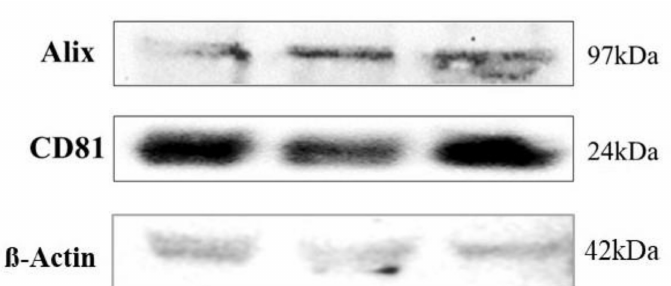
Figure 2. Western Blot results. Characterization of isolated extracellular vesicles by Western Blotting analysis using primary antibodies directed to CD81, Alix and loading control β -actin. Bands were obtained using an exposure of 100 s.